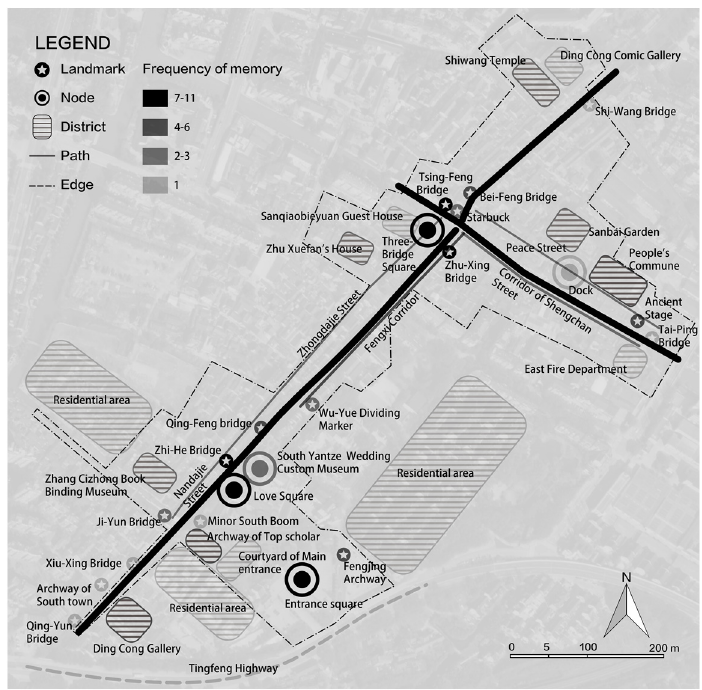
Figure 9. The spatial distribution and frequency of tourists’ cognitive space in Fengjing Ancient Town (source: authors).